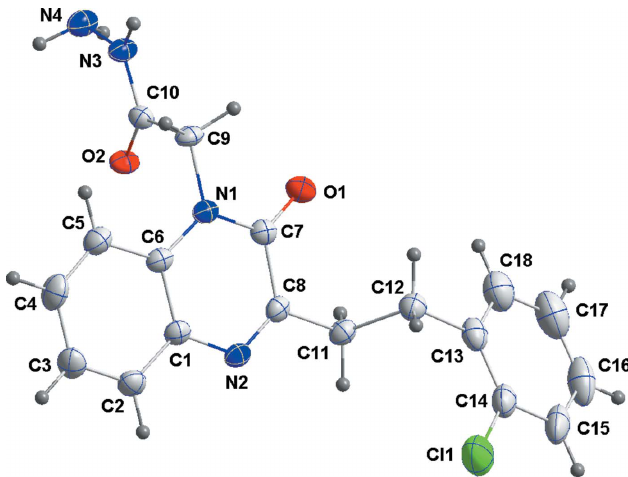
Figure 1 The title molecule with the labelling scheme and 50% probability displacement ellipsoids. Only the major disorder component is shown for clarity.